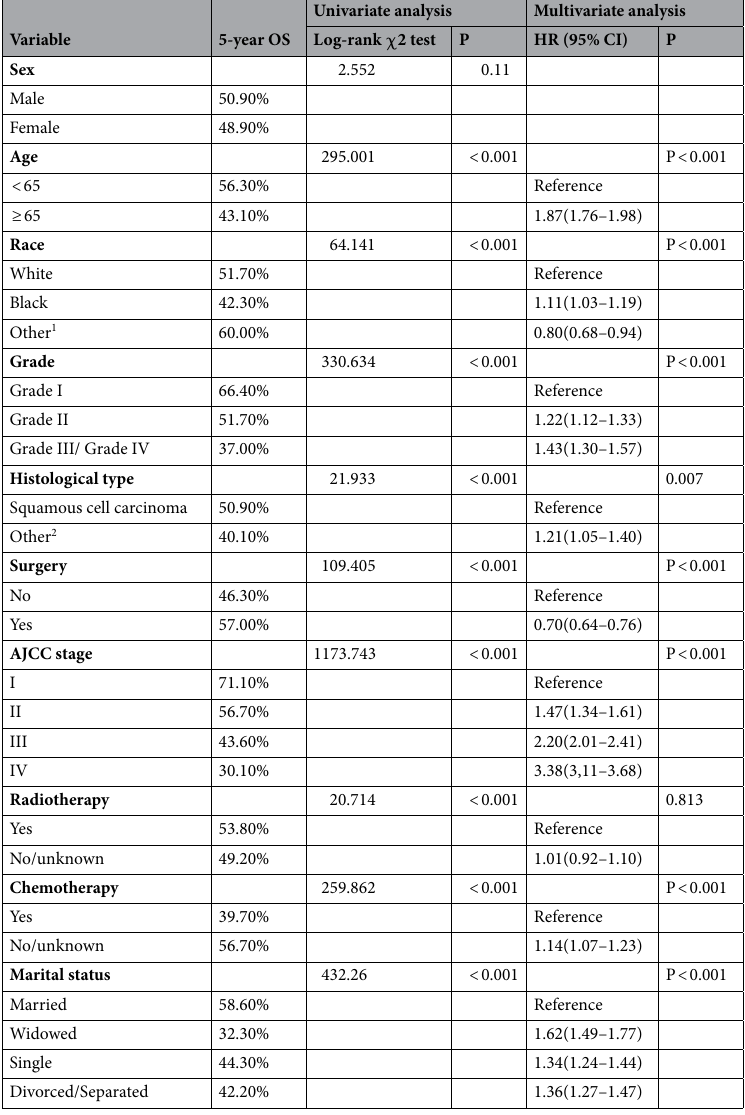
Table 2. Univariate and multivariate survival analysis of OS in laryngeal cancer patients before PSM. Other 1 (Asian or Pacific Islander, American Indian/Alaska Native). Other 2 (Neoplasm, malignant; Carcinoma, NOS; Carcinoma, undifferentiated, NOS; Large cell carcinoma, NOS; Large cell neuroendocrine carcinoma; Spindle cell carcinoma, NOS; Pseudosarcomatous carcinoma; Carcinoma, anaplastic, NOS; Non-small cell carcinoma; Small cell carcinoma, NOS; Papillary squamous cell carcinoma; Verrucous carcinoma, NOS; Combined small cell carcinoma; Papillary carcinoma, NOS; Basaloid squamous cell carcinoma; Lymphoepithelial carcinoma; Basaloid carcinoma; Adenocarcinoma, NOS; Scirrhous adenocarcinoma; Adenoid cystic carcinoma; Neuroendocrine carcinoma, NOS; Mucoepidermoid carcinoma; Papillary carcinoma, follicular variant; Adenosquamous carcinoma; Adenocarcinoma with cartilaginous and osseous metaplasia; Adenocarcinoma with neuroendocrine differentiation; Carcinoma in pleomorphic adenoma). OS, overall survival; PSM, propensity score matching; HR, hazard ratio; CI, confidence